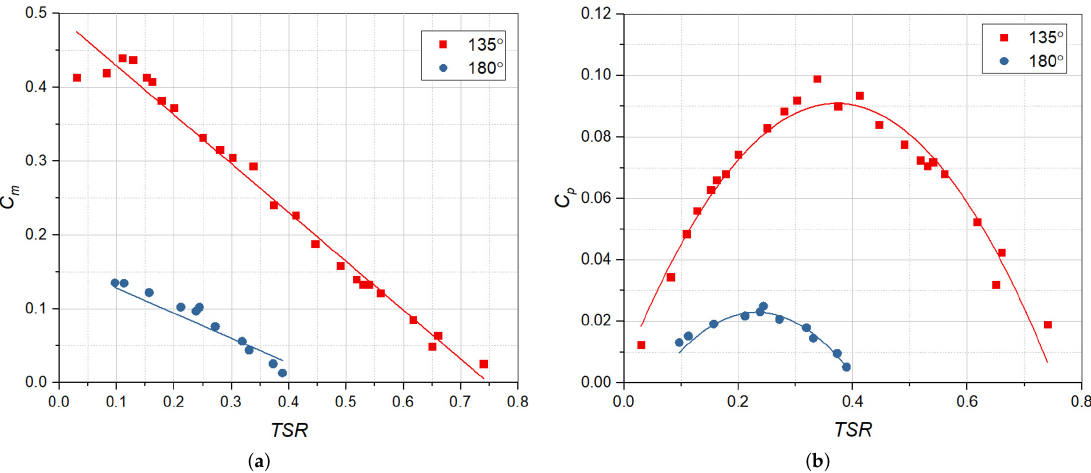
Figure 10. Variation in C m and C p with the TSR for the different blade arc angles ( ψ ). ( a ) C m vs. TSR , ( b ) C p vs. TSR .